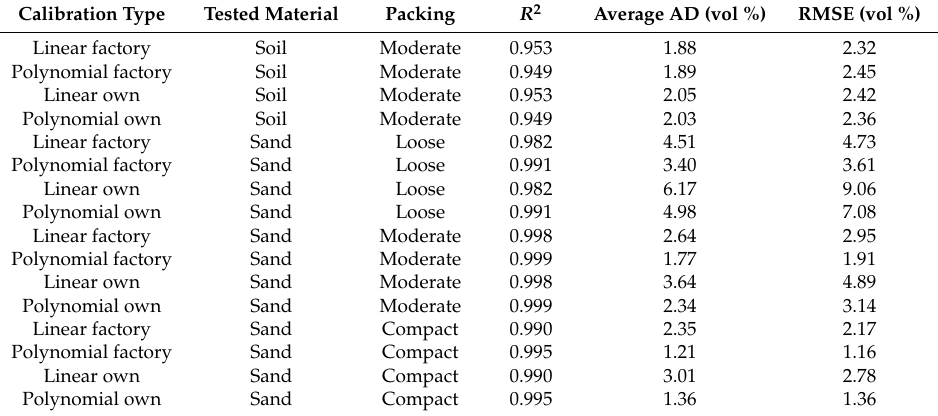
Table 3. Performance comparison of factory and own calibrations for two-point calibration approach of ThetaProbe: R 2 values, average AD (vol %), and RMSE values (vol %).